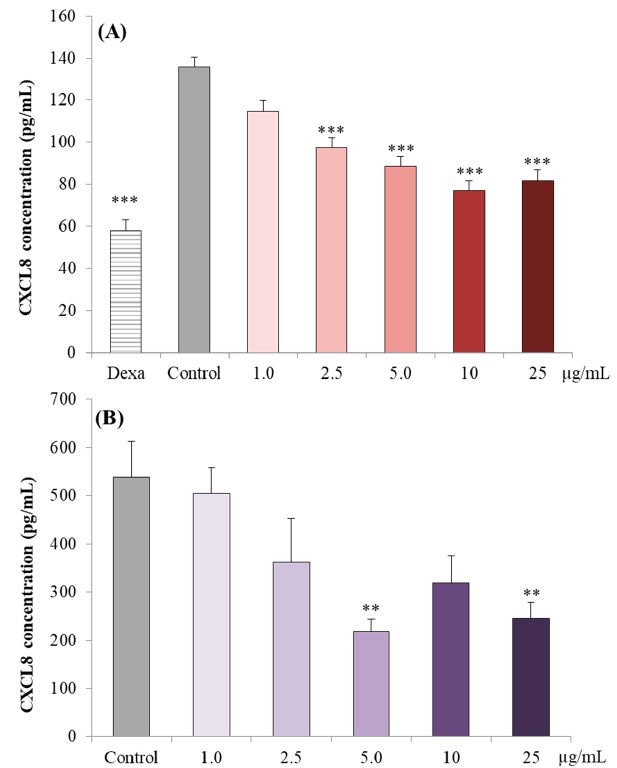
Figure 3. ( A ) Effect of PPE concentrations on CXCL8 concentrations in the supernatant of Caco-2 cells stimulated by TNF and ( B ) in the supernatant of porcine colonic tissue stimulated by lipopolysaccharide (LPS). Supernatants were collected from Caco-2 cells, 24 h post-incubation and from porcine colonic tissues, 3 h post-incubation. Each data point represents n = 3, data presented as mean ± standard error; Dexa = Dexamethasone; *** p < 0.05 and ** p < 0.01 in comparison to control treatment group.